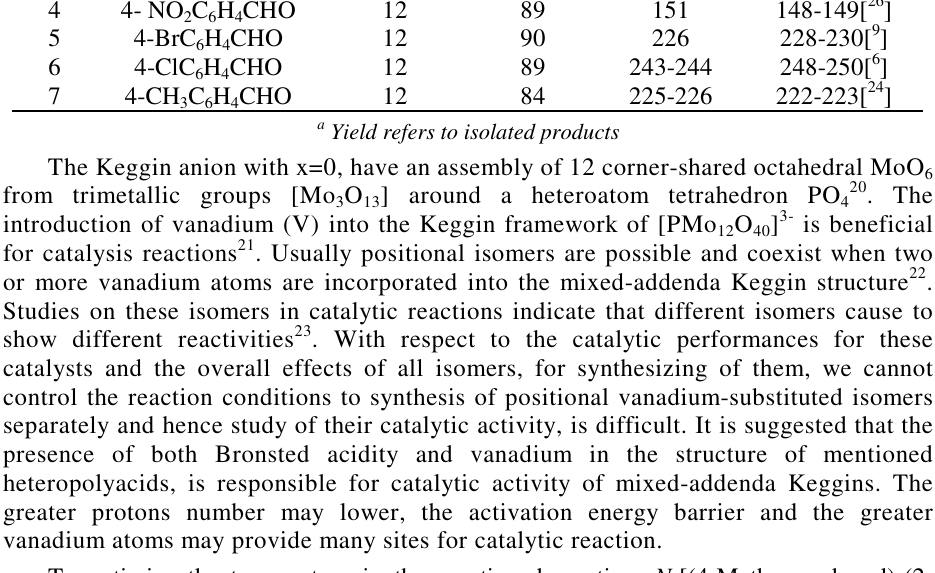
[PMo V O ] 6 9 3 40 mp., o C Found